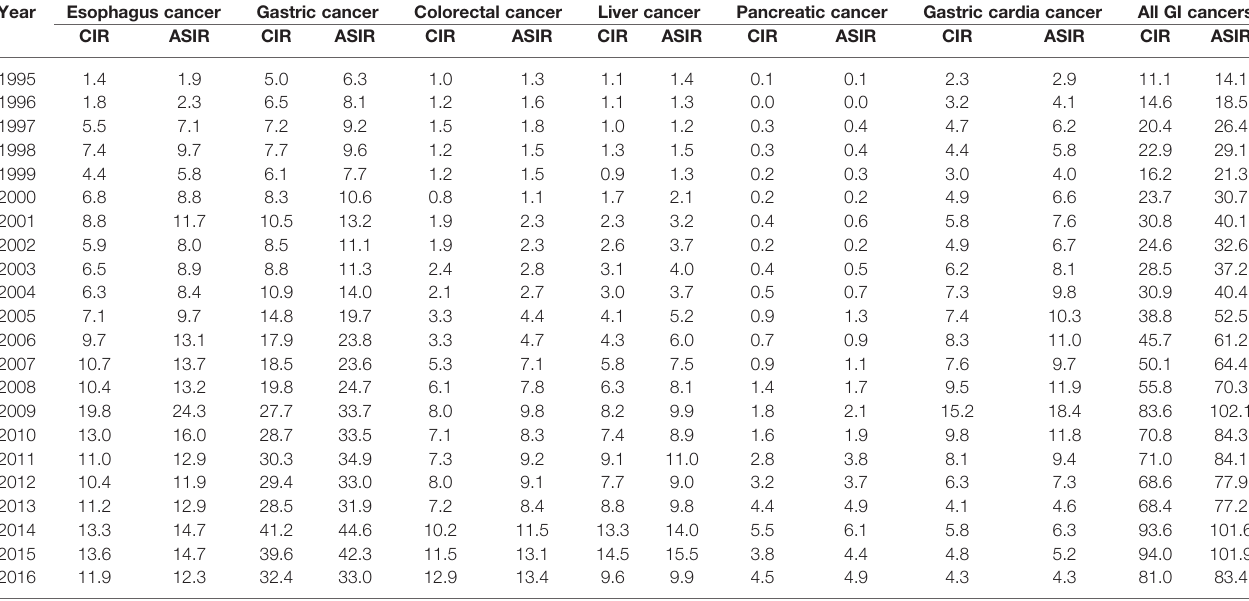
TABLE 2 | Annual crude incidence rates and age-speci fi c and standardized incidence rates (1/100,000 person-years) for GI neoplasms in Wuwei, northwestern China, 1995 –